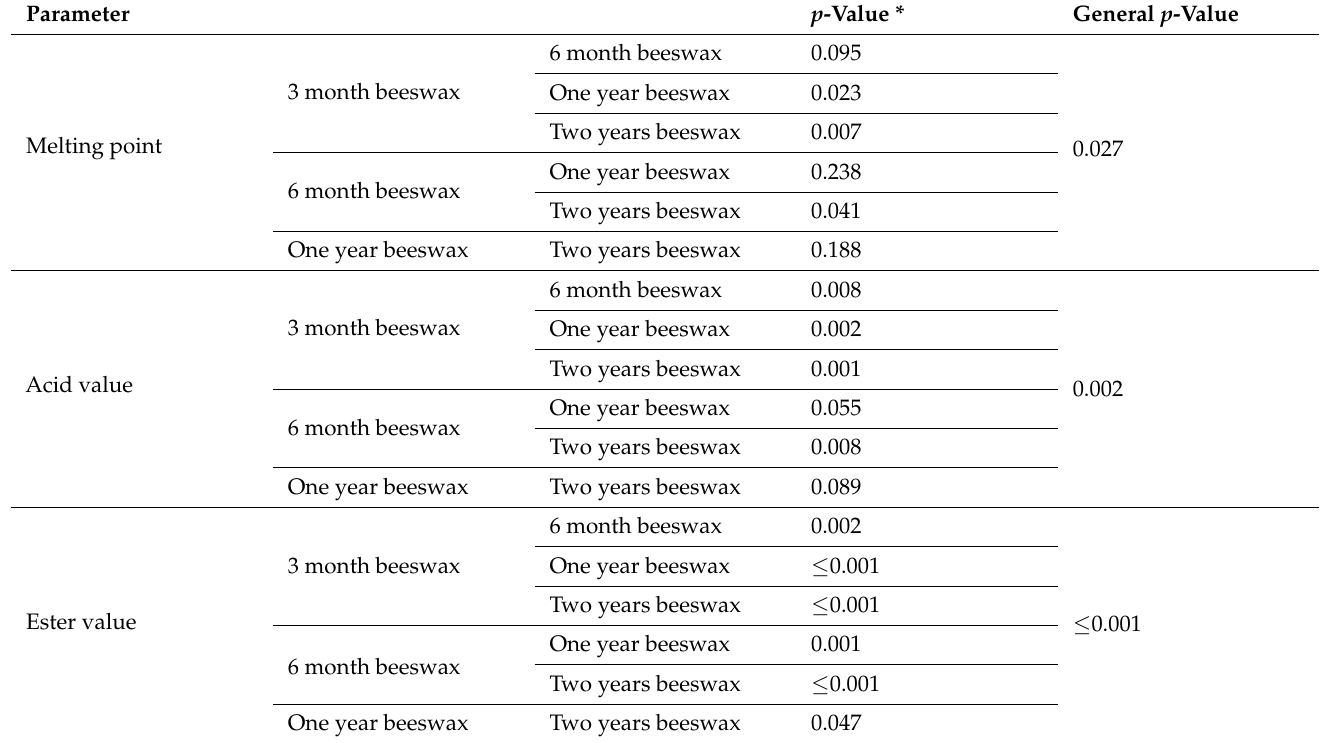
Table 3. Statistical differences between the mean values of the studied